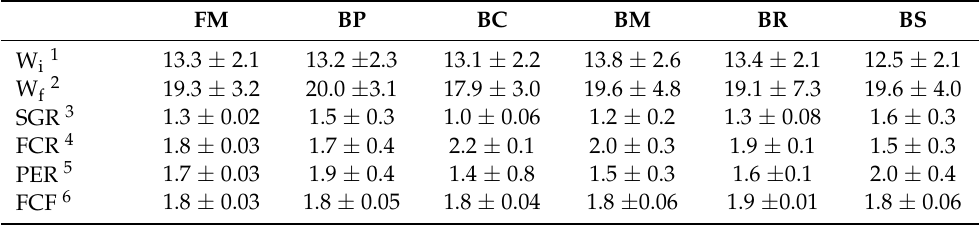
Table 5. Growth performance and feed conversion of tilapia Oreochromis niloticus fed a fishmeal control diet (FM) and five experimental diets with Black soldier fly ( Hermetia illuscens ) meal pro- duced on different substrates (Black soldier fly meal produced on chicken feed (BC), on potato protein (BP), on maize silage (BM), on rapeseed oil cake (BR), on soybean meal (BS)). There were no statistical